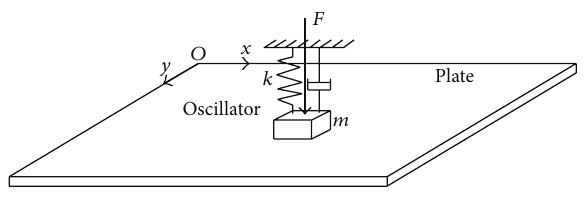
Figure 1: The oscillator-plate